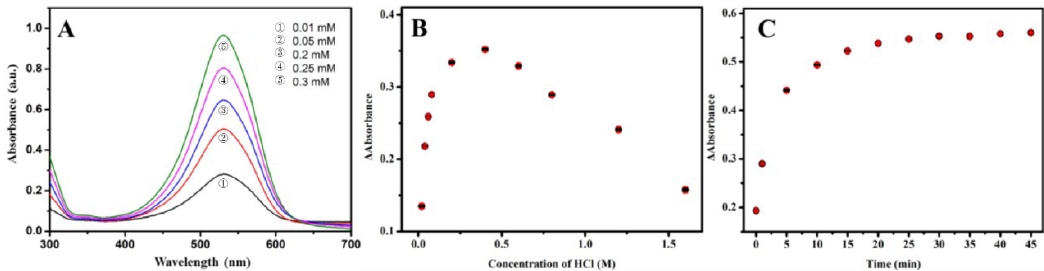
Figure 4. Optimization of concentrations of ( A ) phenosafranin (0.01, 0.05, 0.2, 0.25, 0.3 mM), ( B ) HCl (0.025, 0.05, 0.075, 0.1, 0.2, 0.4, 0.6, 0.8, 1.2, 1.6 M), and ( C ) reaction time (0, 1, 5, 10, 15, 20, 25, 30, 35, 40, 45 min).